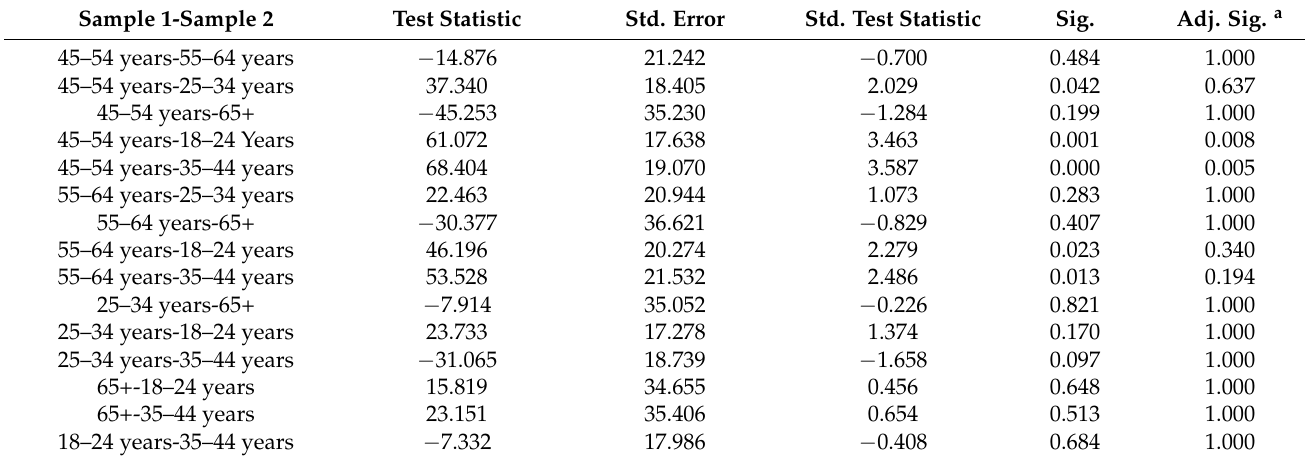
Table 9. Post hoc analysis—Legal issues arising from ownership of art works.